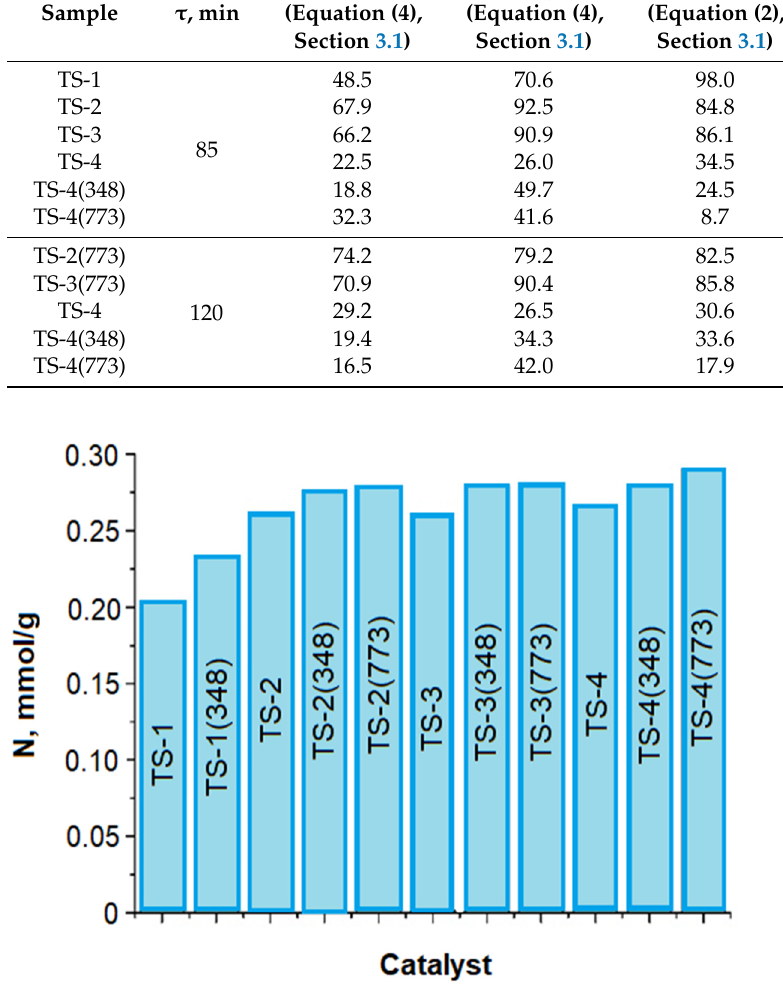
Figure 22. The total acidity of the studied samples (data from